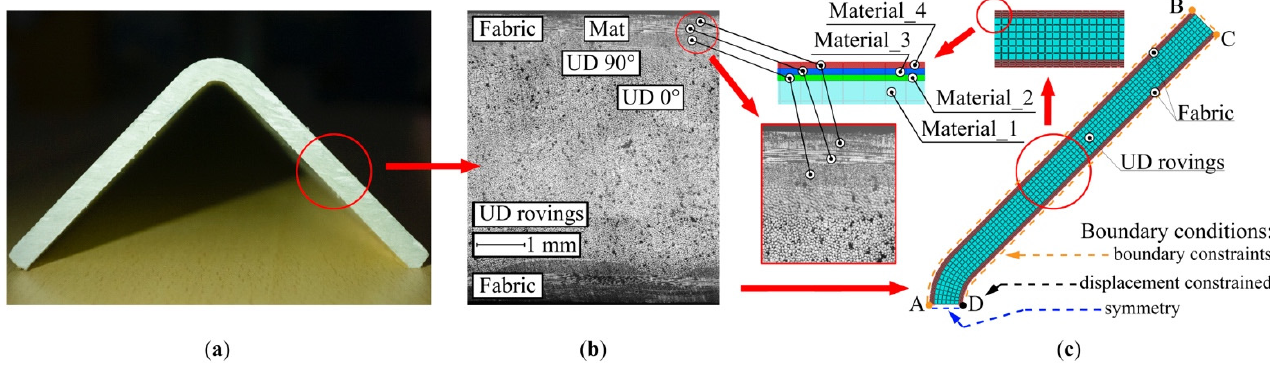
Figure 2. Building the numerical model of a pultruded L-shaped profile: ( a ) Cross-section of the L-shaped pultruded profile; ( b ) Microphotograph of the cross-section of the pultruded profile showing the arrangement of UD rovings and fabric layers; ( c ) Numerical model of the L-shaped pultruded profile built-in ABAQUS software.